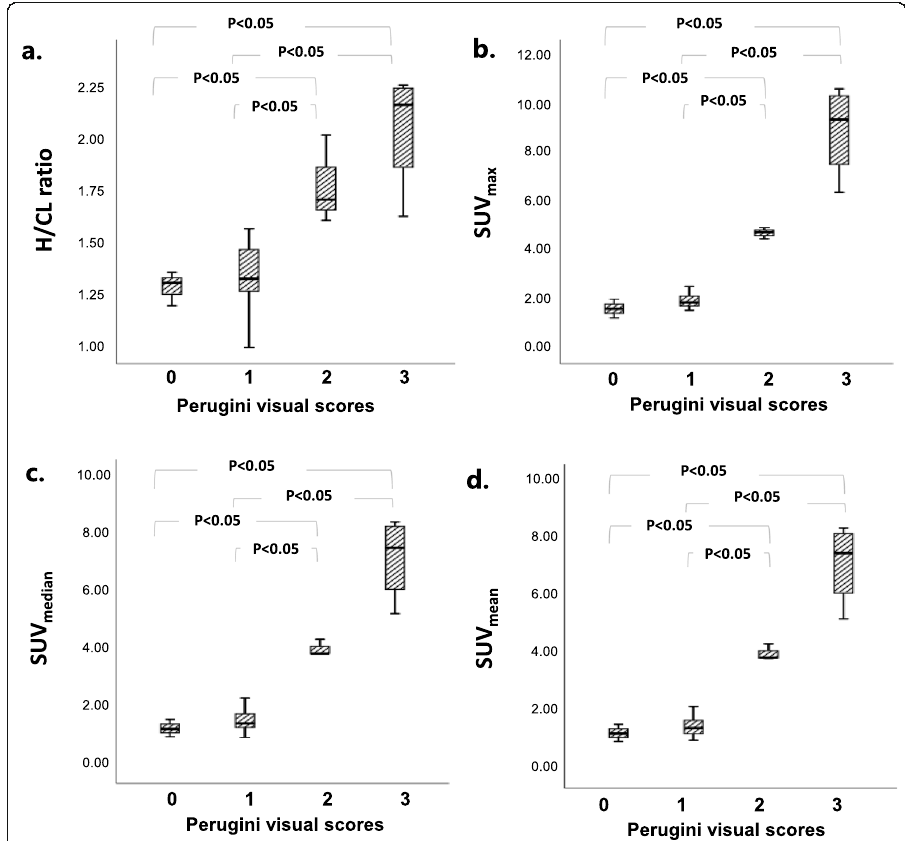
Fig. 3 The box plots of H/CL ratio, SUV max , SUV median , and SUV mean among groups of Perugini visual scores (grades 0 –